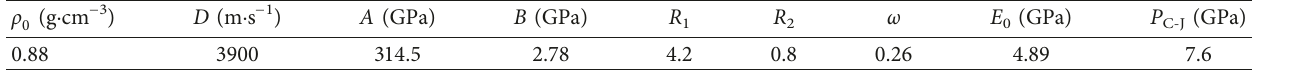
Table 1: JWL parameters for